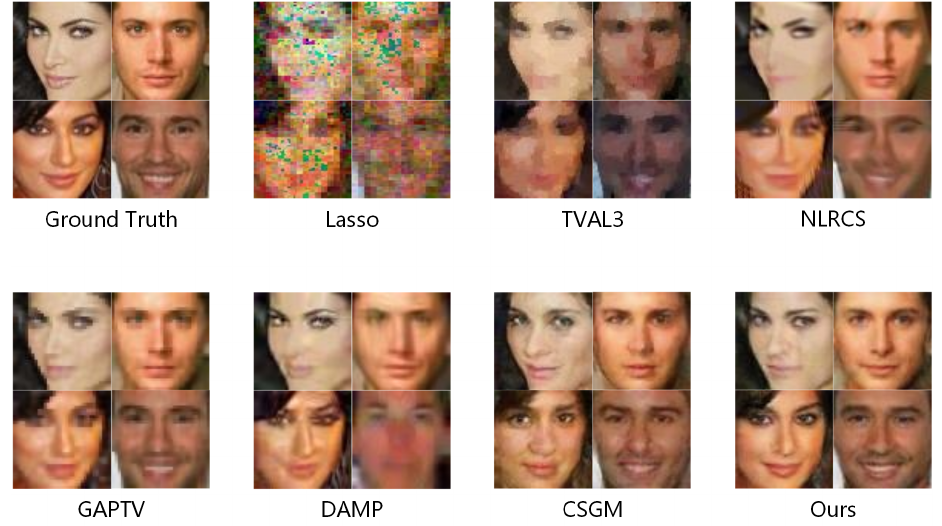
Figure 4. Four examples of face images reconstructed by various methods. The compression rate is set to cr =